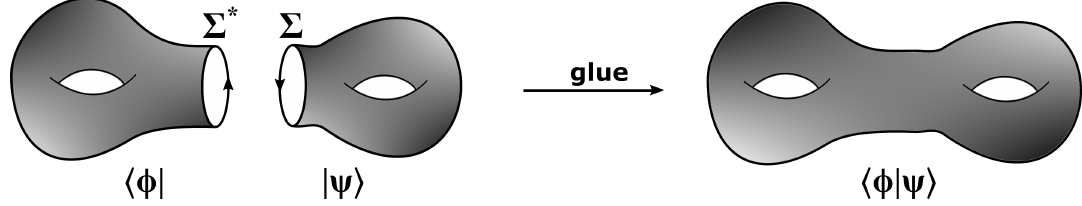
Figure 2. Two manifolds on left with same boundary but opposite orientation. The path integral on these manifolds gives states h φ | ∈ H Σ ∗ and | ψ i ∈ H Σ . The inner product h φ | ψ i will be the partition function of a closed three-manifold (shown in right) obtained by